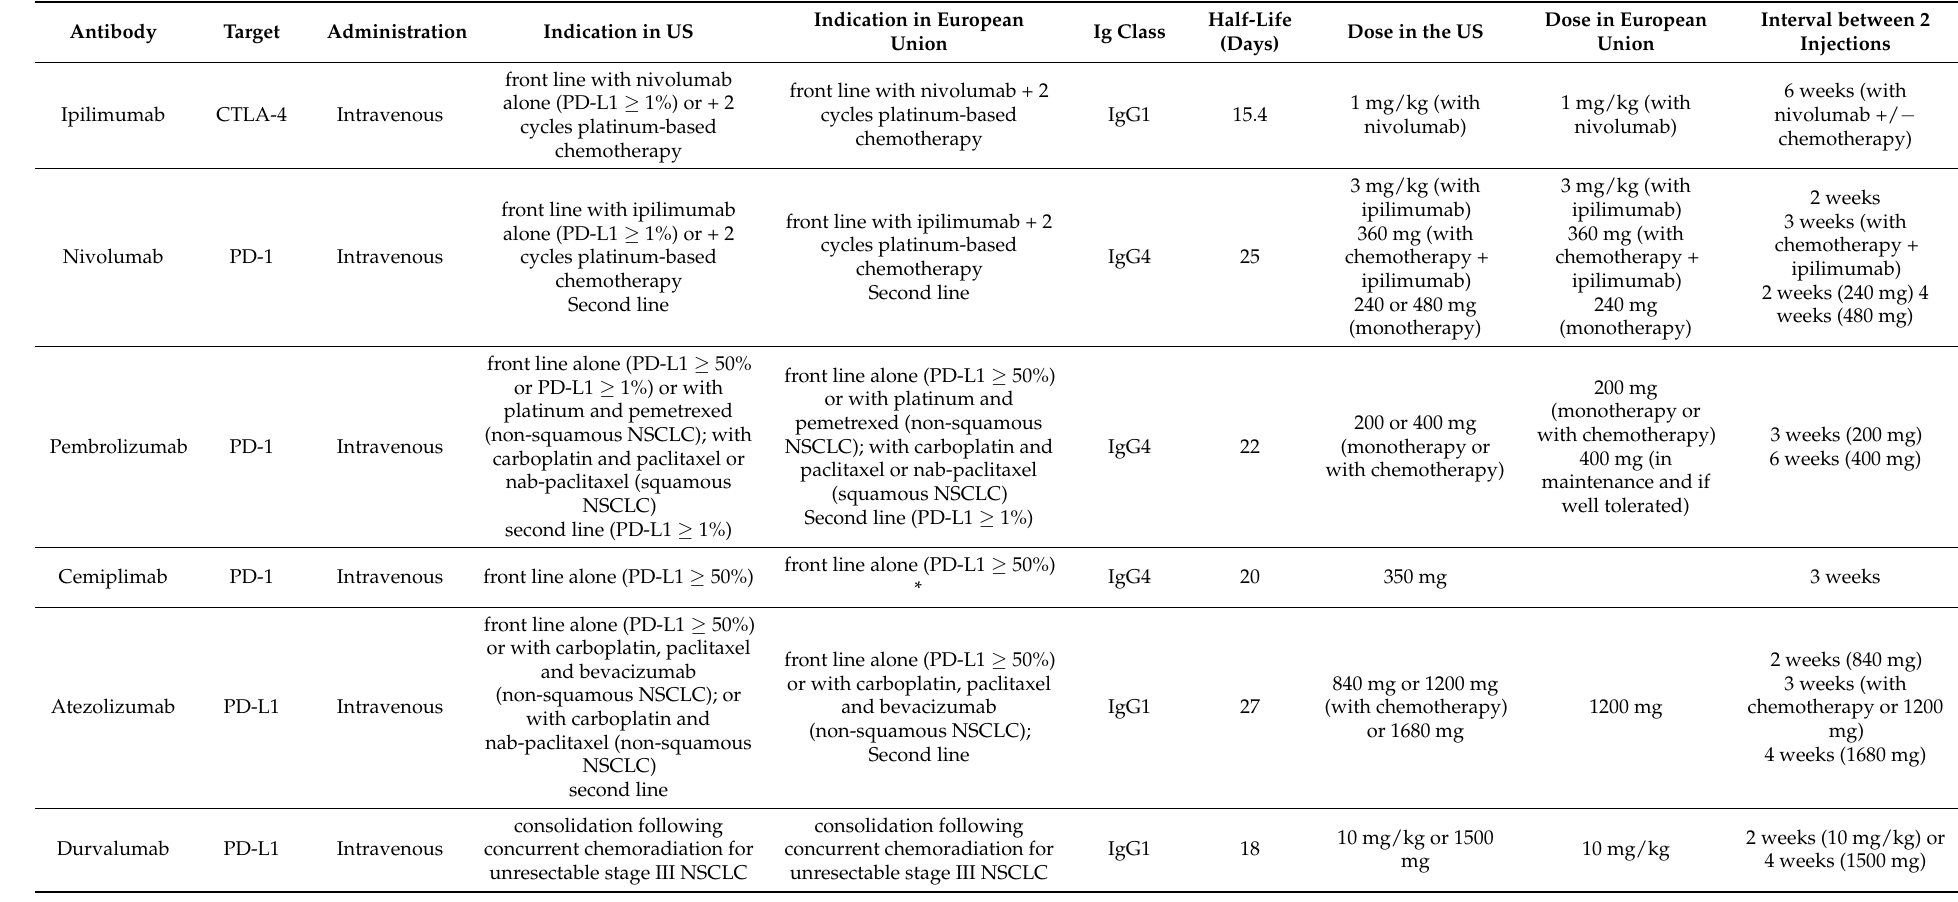
Table 1. Characteristics of marketed antibodies in NSCLC. According to [30]. * European authorization expected